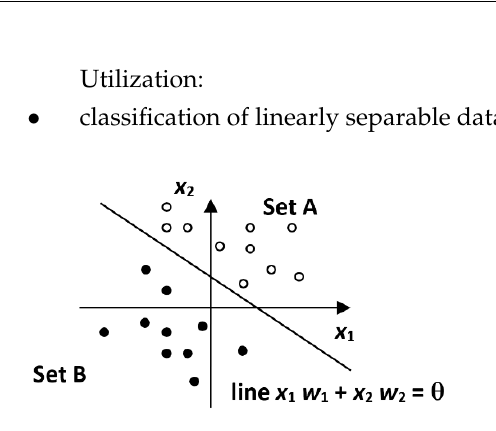
Figure 7. Simple perceptron.